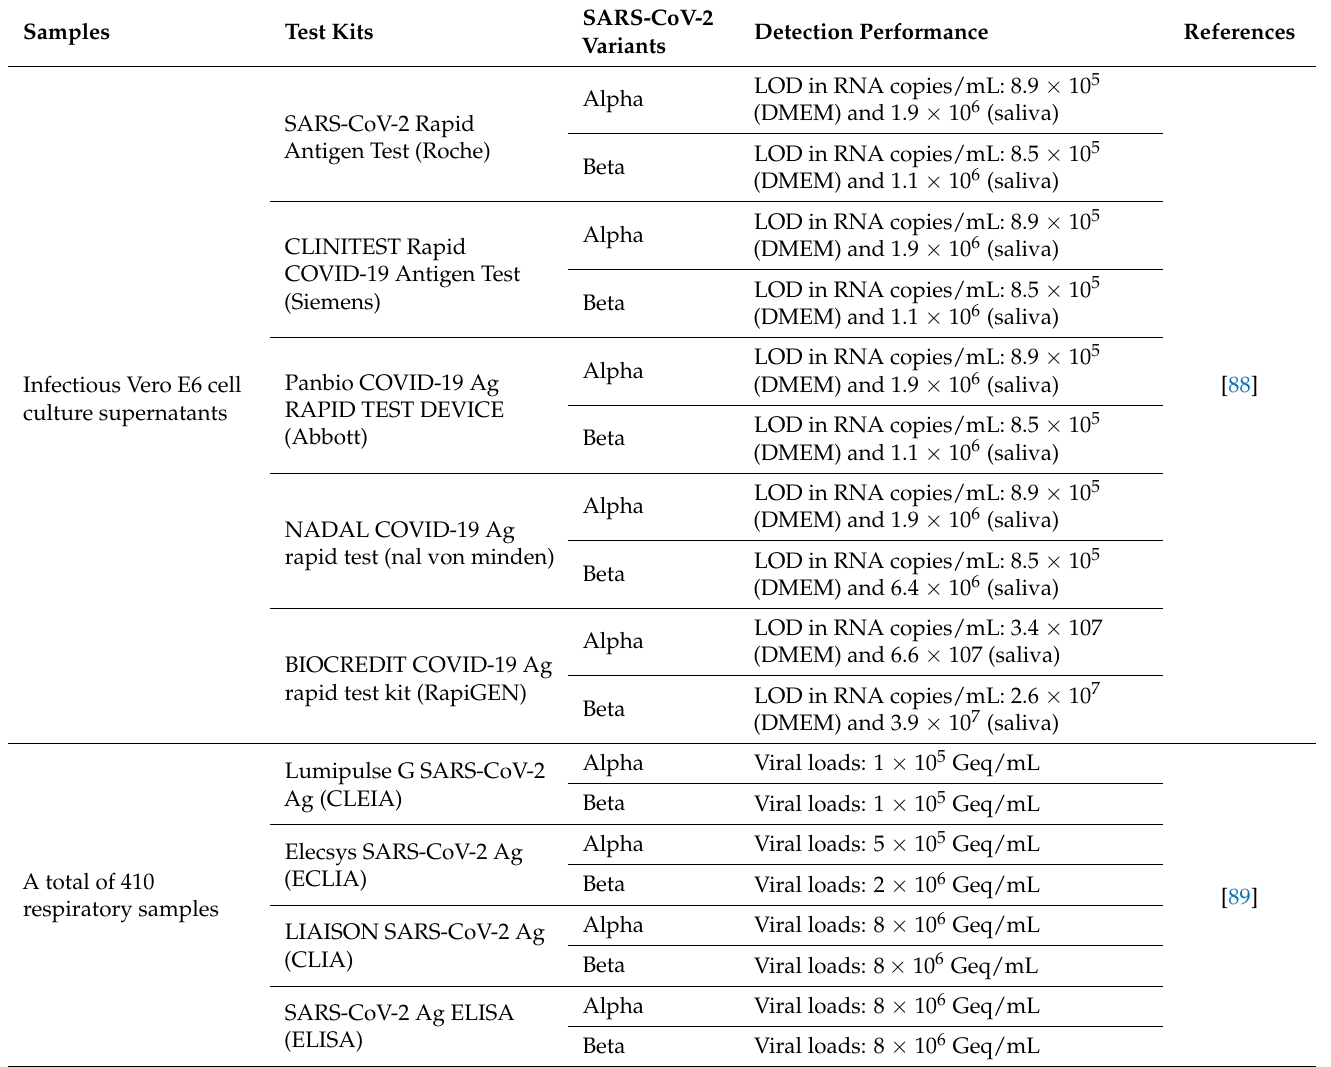
Table 2. Detection Performance of Various RAT Kits for SARS-CoV-2 Variants.